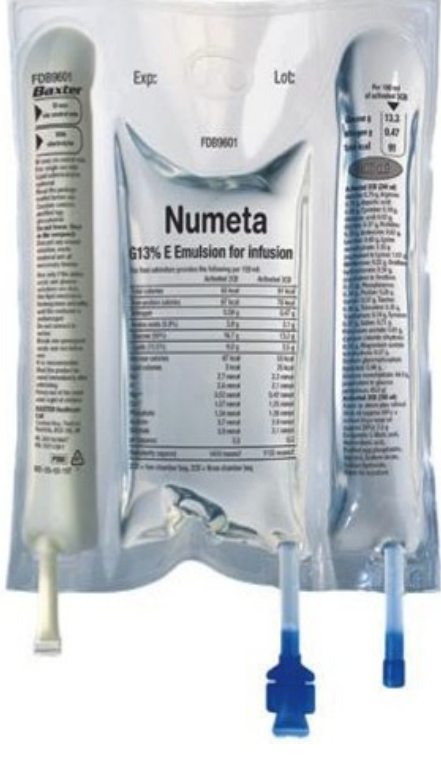
Figure 1. Numeta ® (Baxter ® International Inc.) triple chamber bag for neonatal